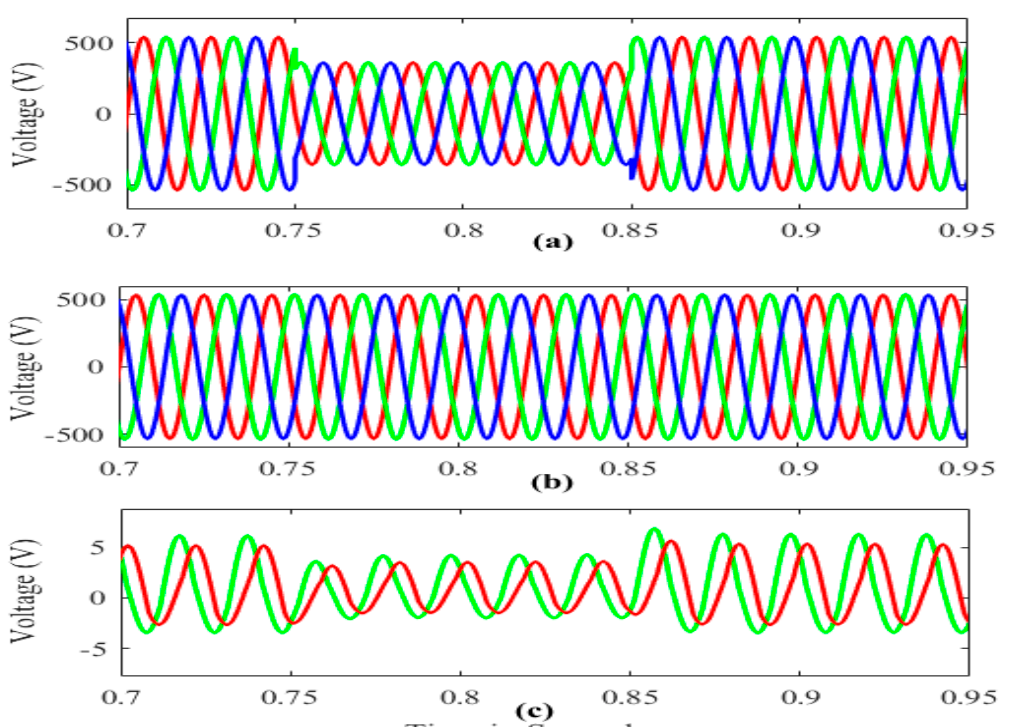
Figure 14. Voltage Sag Condition ( a ) Source Voltage ( b ) Load Voltage ( c ) Injected Voltage.